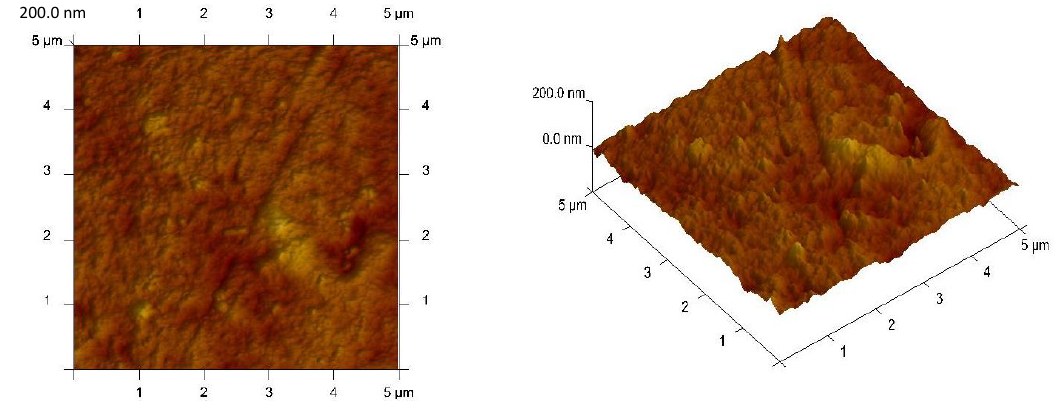
Figure 3. AFM 2D and 3D picture of PIMs doped with ethylenediamine-bis-acetylacetone at a 0.8 mol/dm 3 concentration.